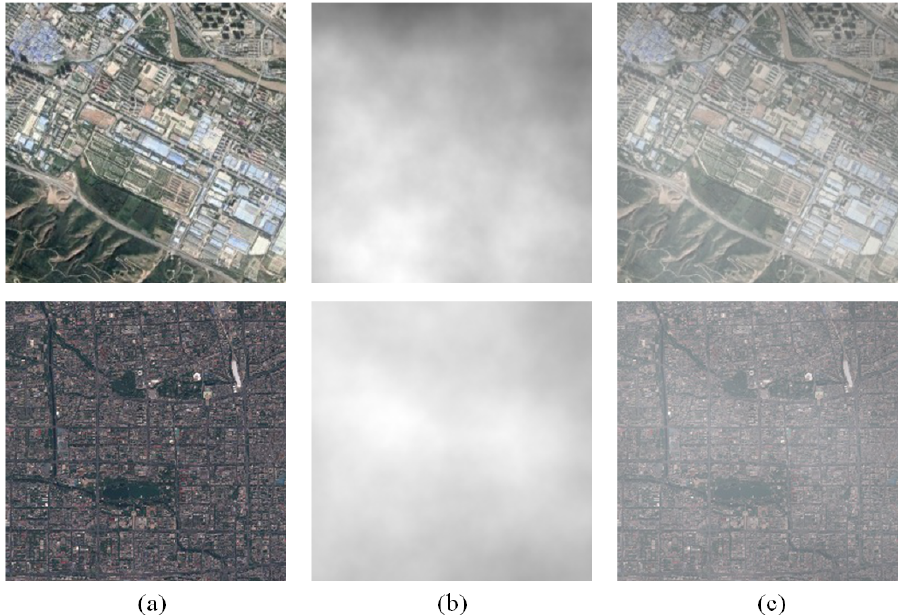
Figure 6. Synthesis of cloudy images: ( a ) reference cloud-free images, ( b ) simulated clouds using Perlin Fractal noise, and ( c ) cloudy images synthesized by alpha